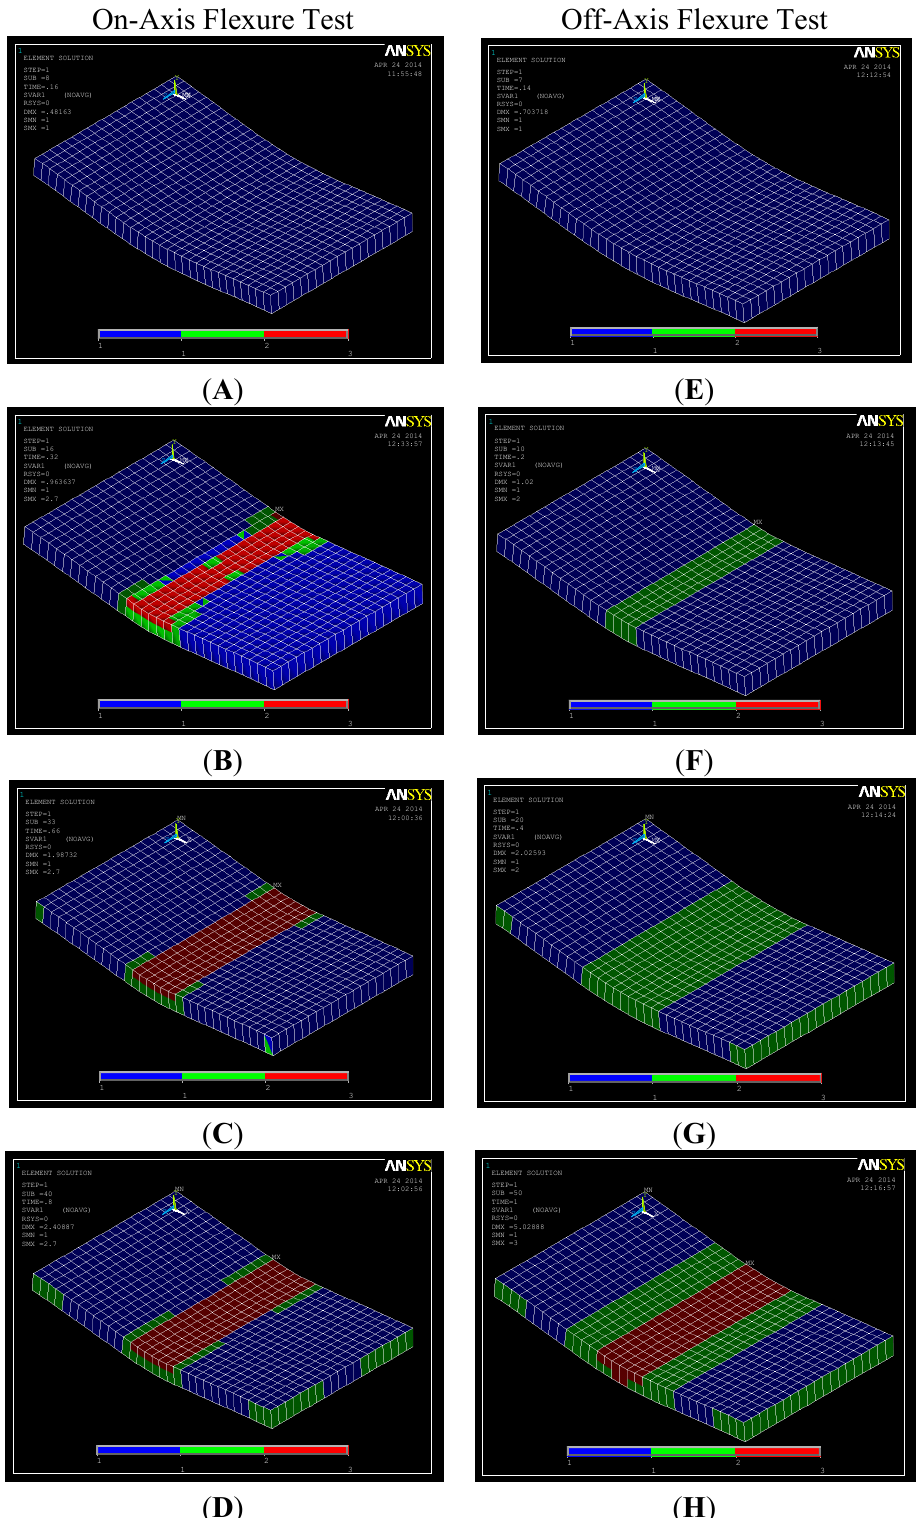
Figure 7. Contour plots for undamaged/damaged matrix and fibers for on- and off-axis flexure test at different strain level. ( A ) ~1.0%; ( B ) ~1.5%; ( C ) ~2.0%; ( D ) ~2.5%; ( E ) ~1.0%; ( F ) ~2.0%; ( G ) ~4.0%; ( H )